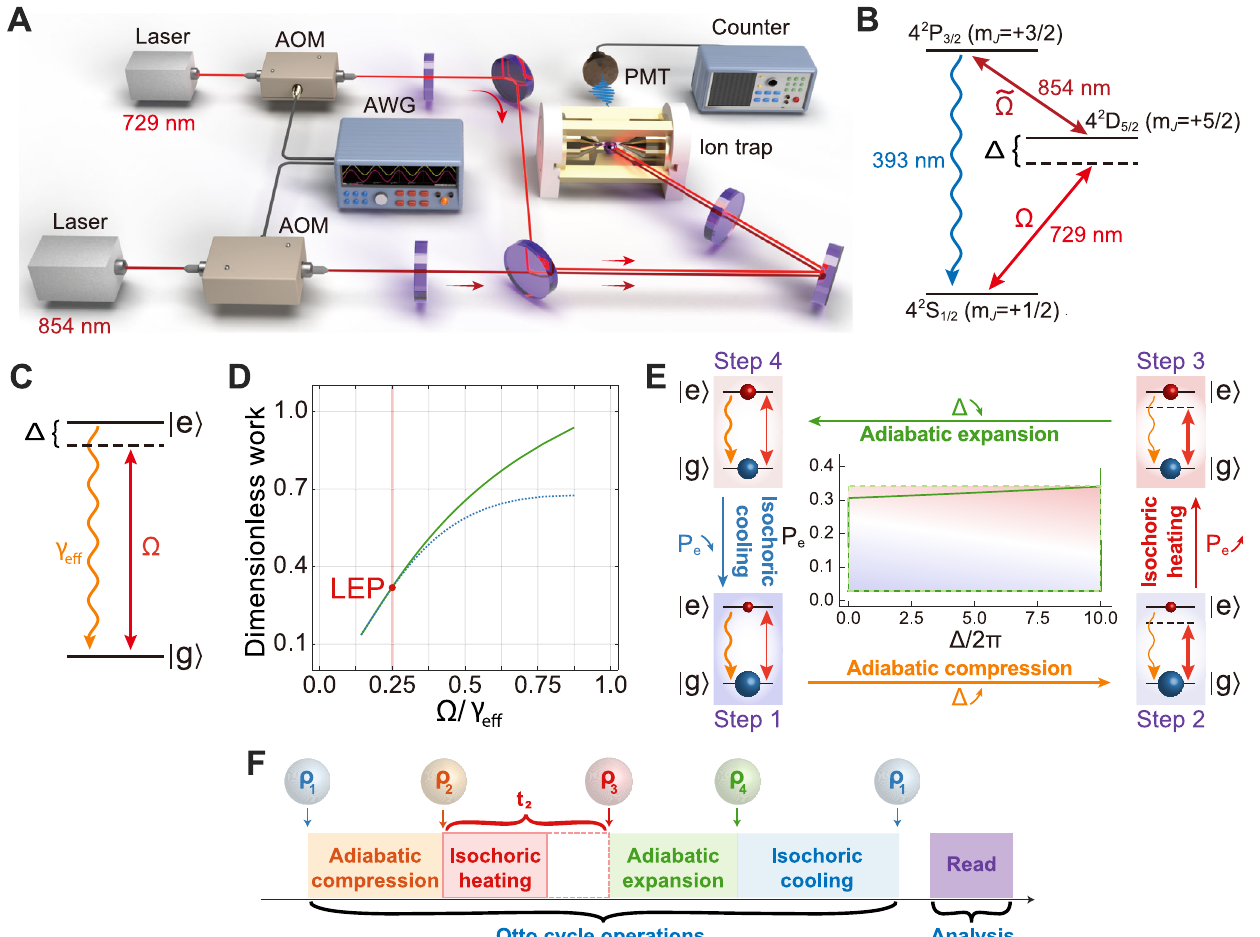
Fig. 1 | Single-spin quantum heat engine in a trapped 40 Ca + ion exhibiting a Liouvillianexceptionalpoint(LEP).A Schematicoftheexperimentalsetup.AOM: acousto-optic modulator. PMT: photomultiplier tube. AWG: arbitrary waveform generator. B Energylevels of the 40 Ca + ion, wherethestraight red arrowsrepresent transitions by laser irradiation with wavelengths labeled and the blue wavy arrow denotesspontaneousemission.Suchathree-levelcon fi gurationequalsaneffective two-levelsystemwithcontrollabledrivinganddecay,asplottedin( C ). D Schematic diagramforworkdoneintheexact-andbroken-phasesseparatedintheparameter space by an LEP at Ω / γ eff =1/4, where a bifurcation occurs due to